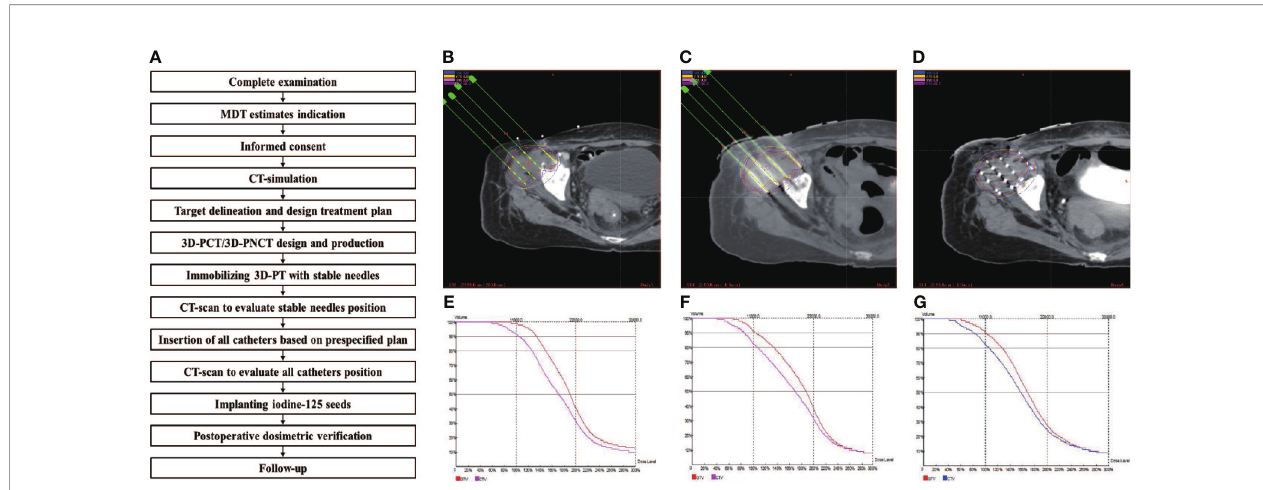
FIGURE 2 | Example of the successive steps in 3D-PT assisted I-125 BT procedure. (A) the implantation work- fl ow. CT-image acquisition for target delineation, treatment planning and optimization: (B) preoperation, (C) intraoperation, and (D) postoperation; DVH for treatment planning optimization and veri fi cation: (E) preoperation, (F) intraoperation, and (G)